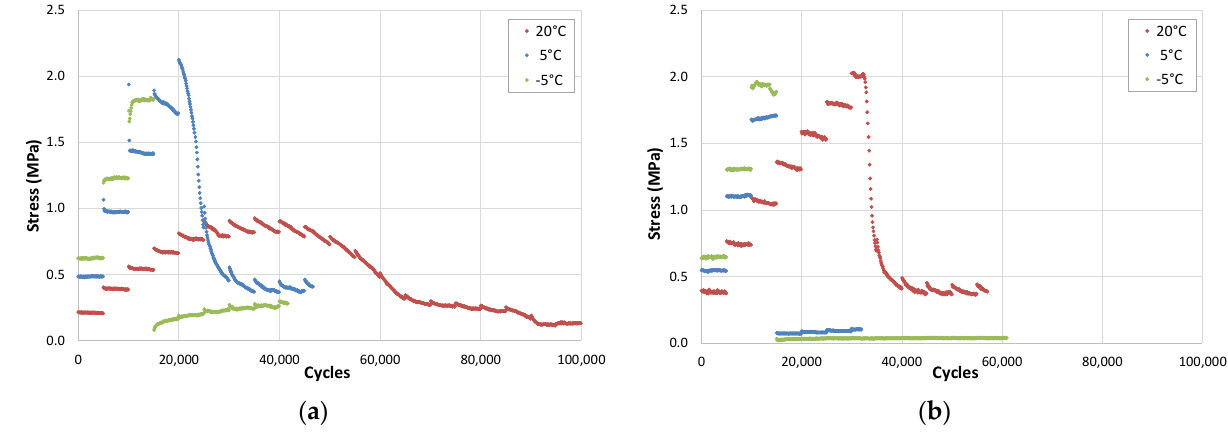
Figure 15. ( a ) Stress evolution for unaged mixtures and ( b ) Stress evolution for aged mixtures, at different test temperatures.